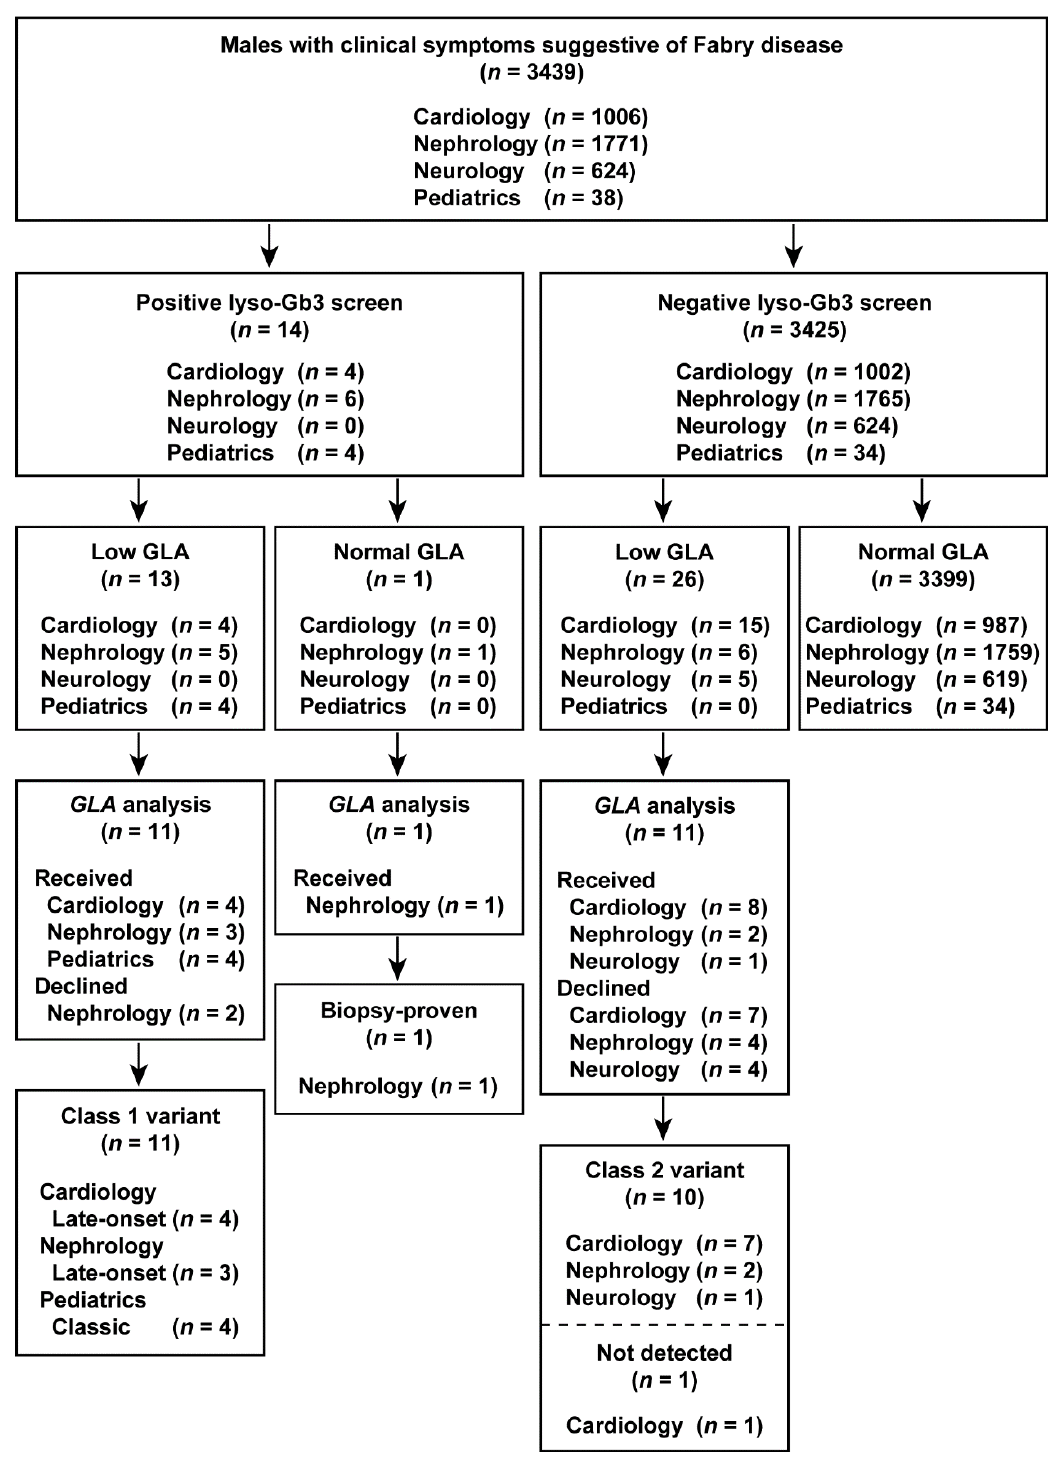
Figure 2. Flowchart of the combination of lyso-Gb3 and GLA activity screening and GLA analysis in male patients. Male patients enrolled between 1 July 2014 and 31 December 2016.